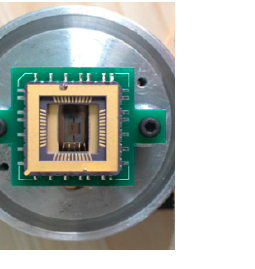
Figure 12. Prototype of the MEMS electronic heart sound sensor.